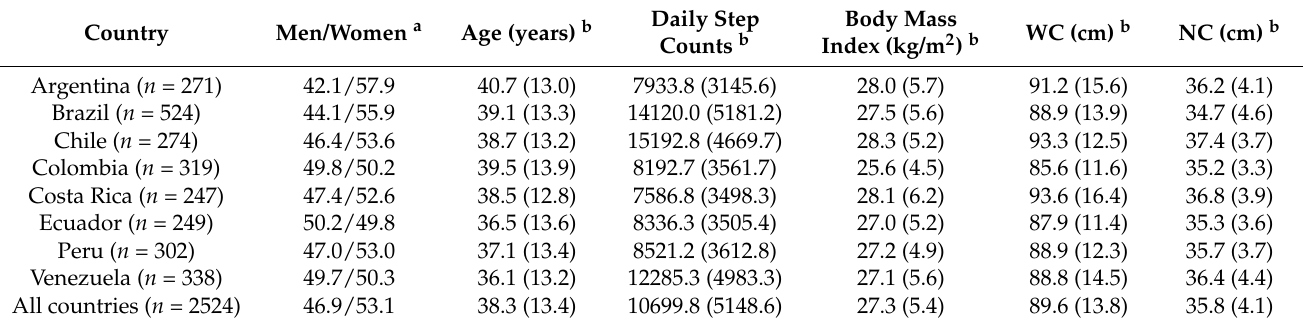
Table 1. Descriptive characteristics of the participants stratified by country.